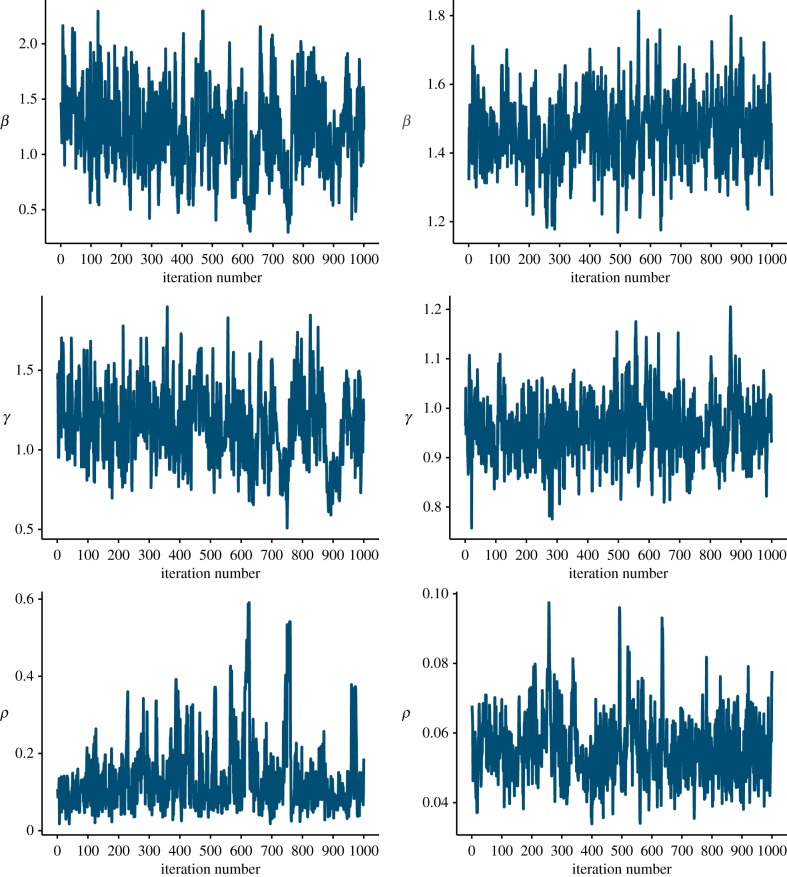
The thinned trace of a single Markov chain in the MCMC implementation of Method 3 for the smaller cut-off time (T = 3). Separate panels are shown for each of the parameters β, γ, and ρ. The left-hand panels correspond to n = 102, and the right-hand panels correspond to n = 103. The true parameter values are β = 1.5, γ = 1 and ρ = 0.05 (parameter setting θ3). (Online version in colour.)